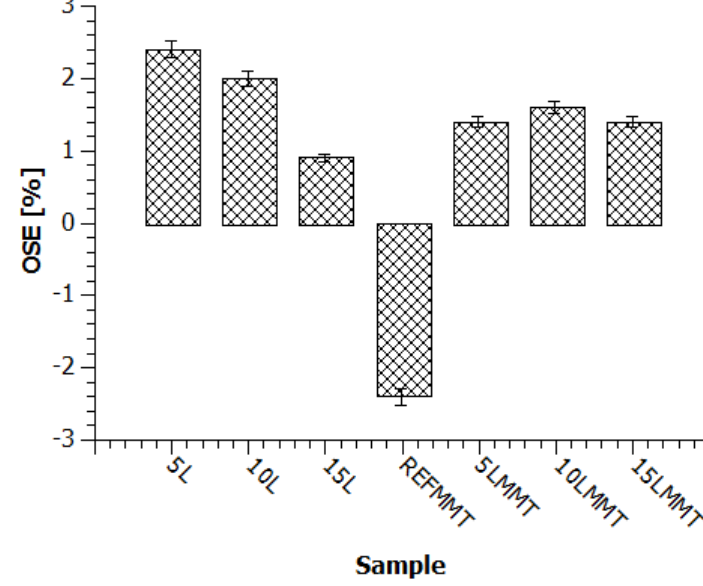
Figure 3. Overall thermal stabilization e ff ect of the triple layers on polyamide 6.